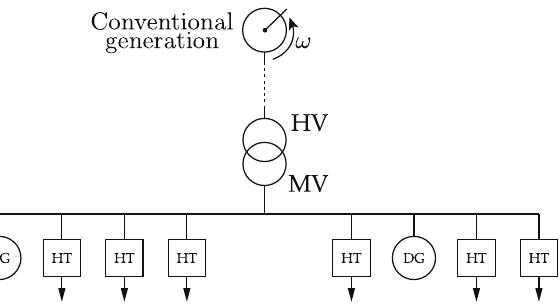
Figure 24. Active distribution grid voltage regulation by means of